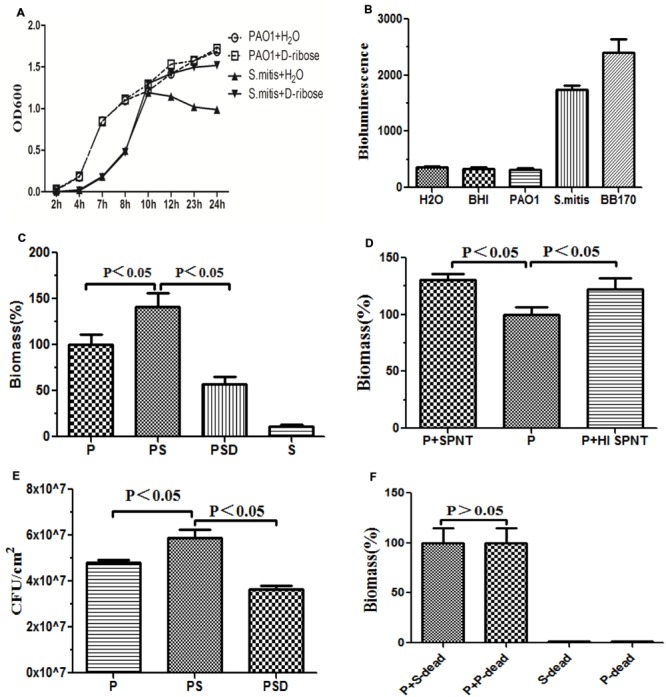
Quantification of biofilm formation by crystal violet staining. Quantification of the biofilm biomass by spectrophotometry (OD 570). The error bars indicate standard deviations. P represents PAO1 group; PS represents PAO1&S. mitis group; PSD represents PAO1&S. mitis group co-culture with D-ribose (50 mM). (A) Effects of D-ribose on planktonic growth of PAO1 and S. mitis. Cells were grown in BHI medium, in the presence of 50 mM concentrations of D-ribose or dH2O. The data represent mean values of three independent experiments. (B) The biomass of co-cultured PAO1 and S. mitis was significantly higher than that of co-cultured PAO1 and S. mitis with 50 mM D-ribose and mono-cultured PAO1 or S. mitis. (C) PAO1 was exposed to fresh spent supernatant (SPNT) or heat-treated supernatant (HI SPNT) from S. mitis. Both the SPNT and the HI SPNT from S. mitis could increase the biomass of the PAO1 biofilm. (D) Bacterial colony counts of mono- and dual-species biofilms. (E) No significant difference was found between co-cultures of PAO1 with dead S. mitis cells and co-cultures with dead PAO1 cells. ‘P-dead’ represents dead PAO1 cells, and ‘S-dead’ represents dead S. mitis cells. (F) Bioluminescencing activity of partially purified S. mitis AI-2 and BB170 (AB medium for V. harveyi, BHI for S. mitis and PAO1).